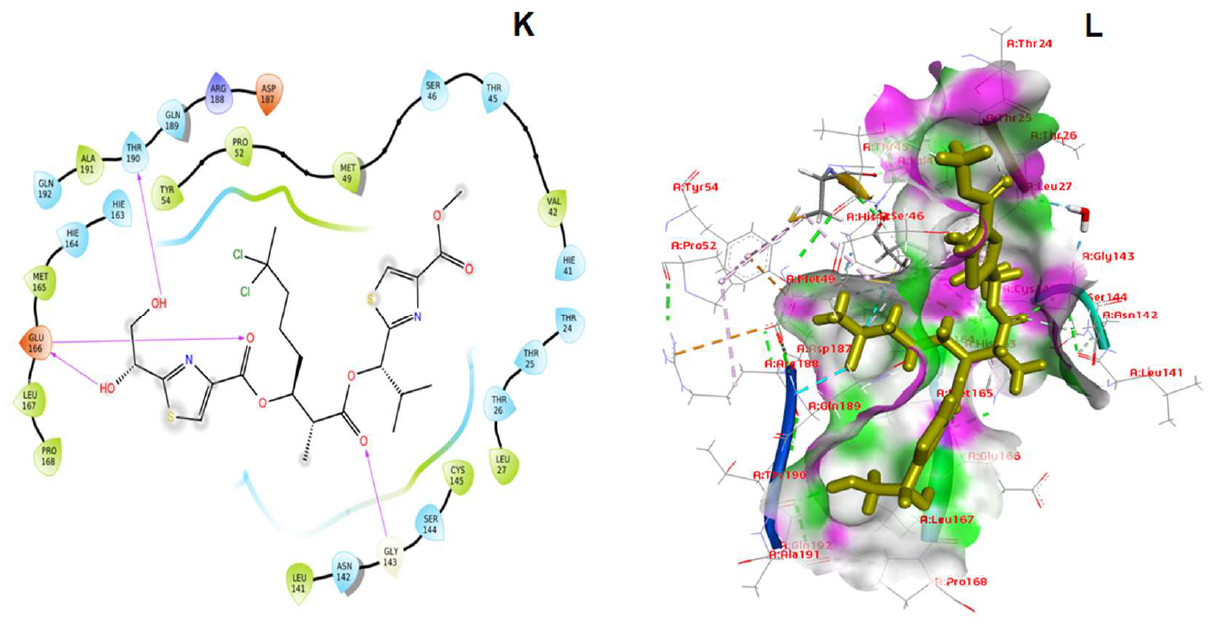
Figure 6. ( I , J ) Illustrations of the interaction between Kappa-Carrageenan and the target M pro protein of SARS-CoV-2.